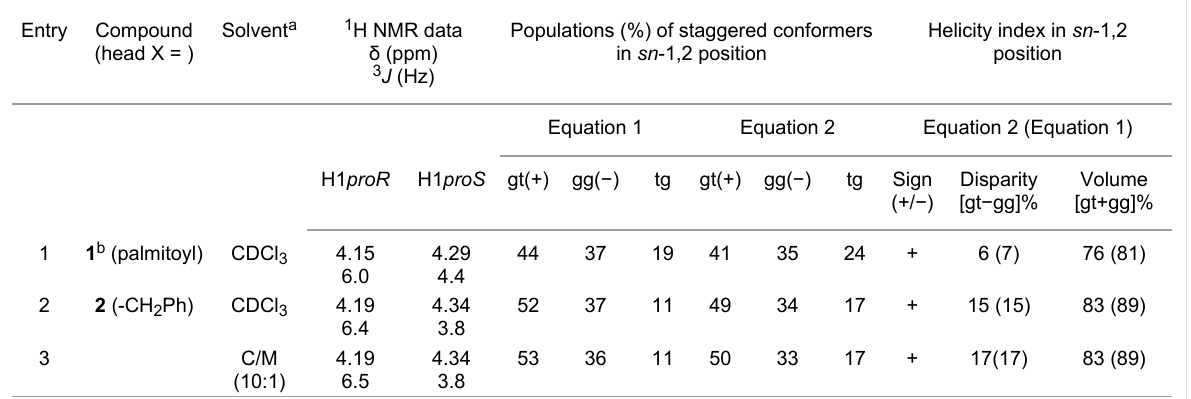
Table 1: 1 H NMR data and helical conformational properties of tripalmitin 1 and 3- O -benzyl derivative 2 in the solution state.